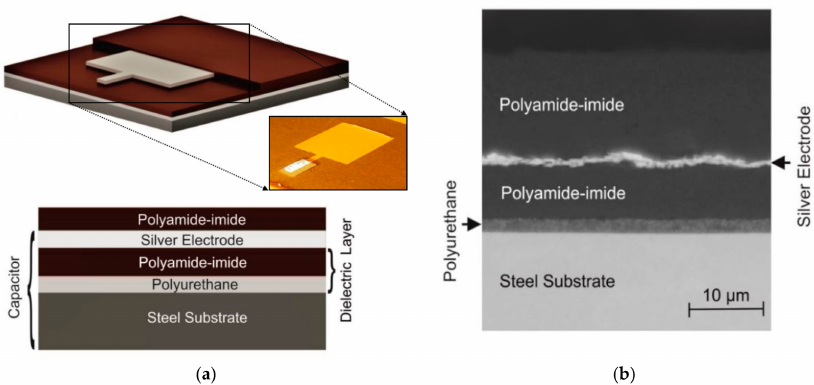
Figure 1. ( a ) The sensor design: A three-dimensional (3D) view (picture and schematic) and a cross section (schematic) which show the layered structure of the sensor, consisting of two conductive layers (steel substrate and silver electrode) and two dielectric layers (polyamide-imide and polyurethane); ( b ) A scanning electron microscopy cross section polish of a fabricated